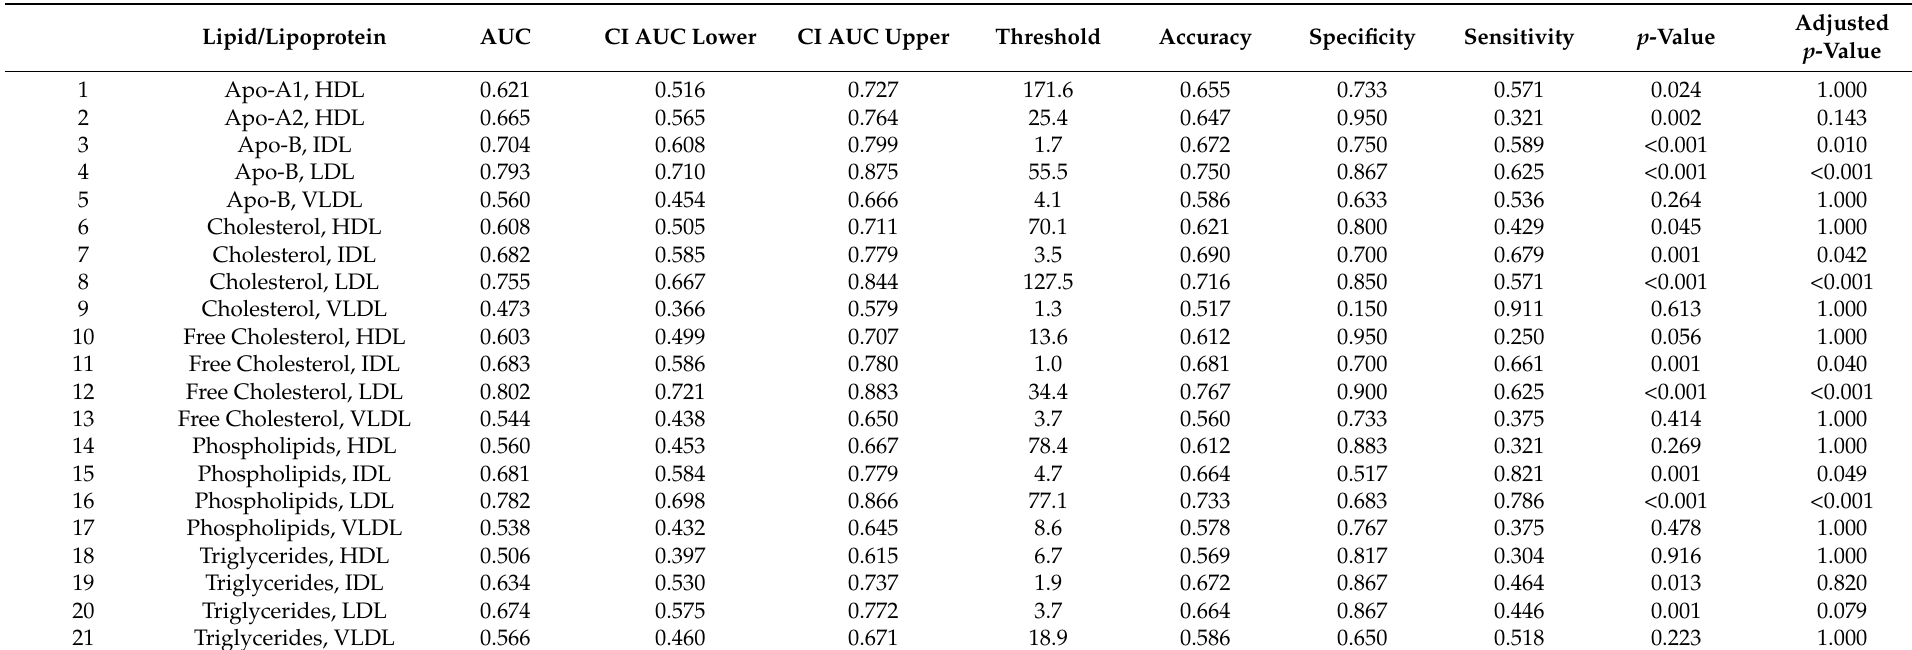
Table 5. ROC analysis of the concentrations of lipoprotein main fractions in young and old women. Age groups are defined in Table 1. Concentrations are in mg/dL. Adj stands for adjusted. CI indicates the 95% Confidence